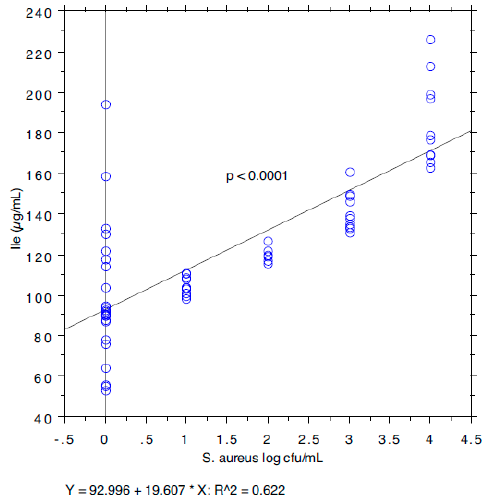
Figure 2. Pearson correlation between isoleucine content and S . aureus load.